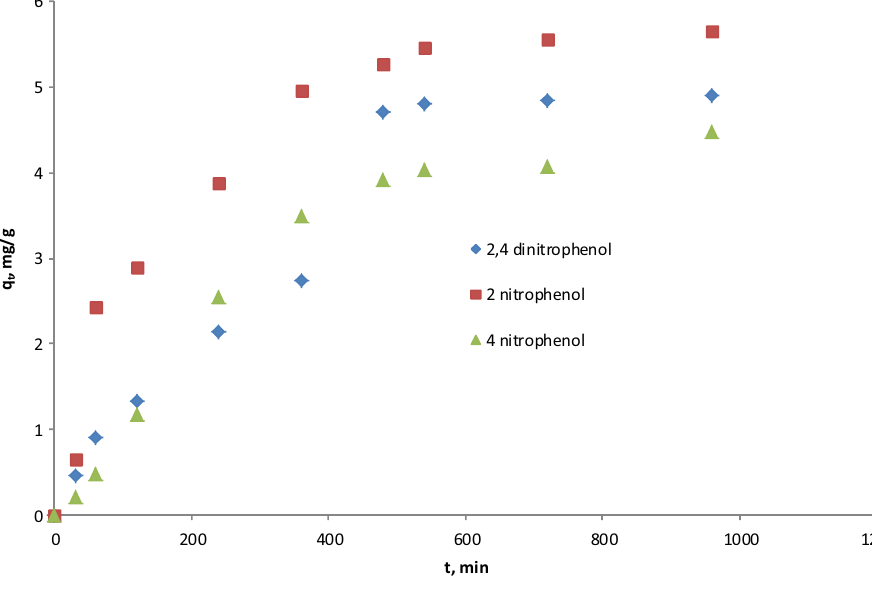
Fig. 8 Effect of contact time on adsorption of phenols on char ash